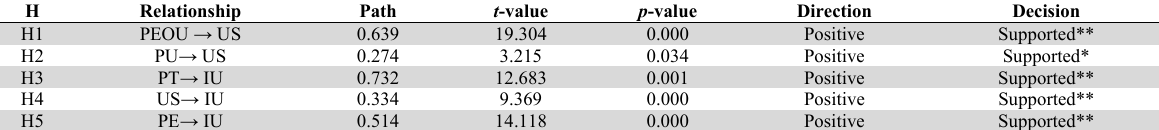
Hypotheses-testing of the research model (significant at p** < = 0.01, p* < 0.05)